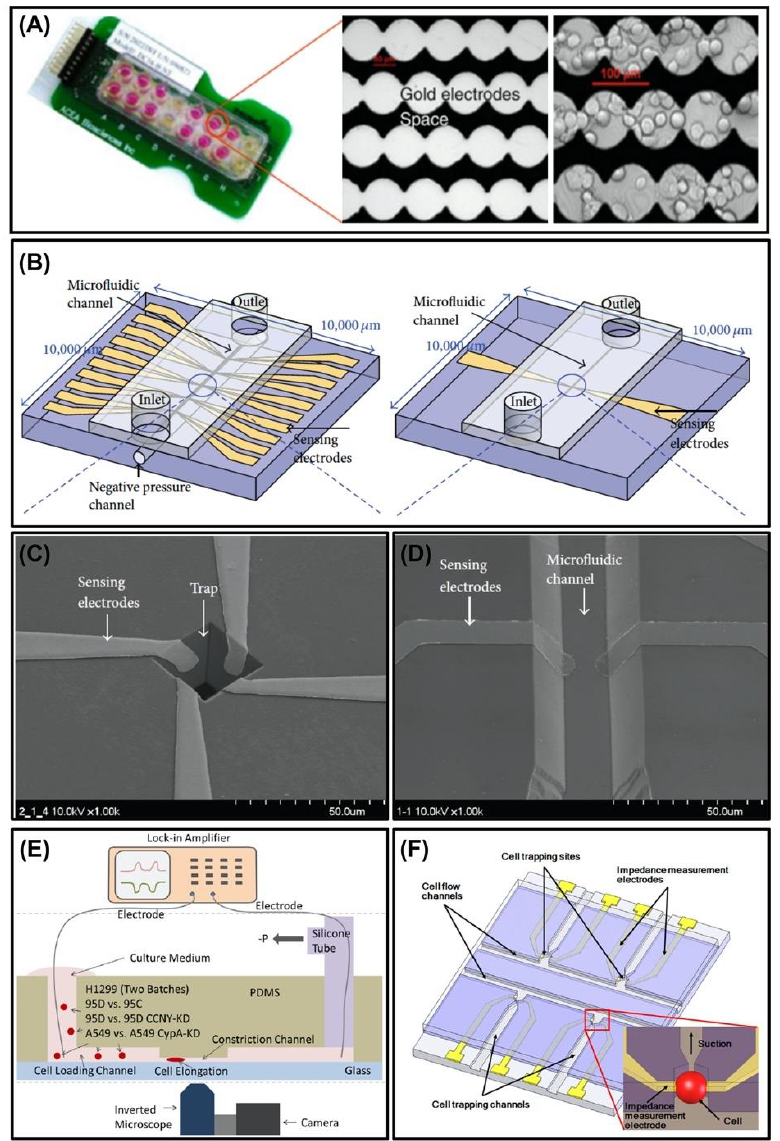
Figure 5. Schematics of ( A ) ECIS microdevice for adhered cells [58] and ( B ) EIS (left) and IFC (right) [59] microdevices for cell suspensions used in impedimetric measurements. Micrographs of planar electrodes for both ( C ) ECIS and ( D ) IFC microdevices [59]. Microdevice schematics of ( E ) IFC system with a microchannel constriction [48] and ( F ) EIS with cell trapping [51] for single cell impedimetric measurements. Reprinted with permission from [48,51,58,59].